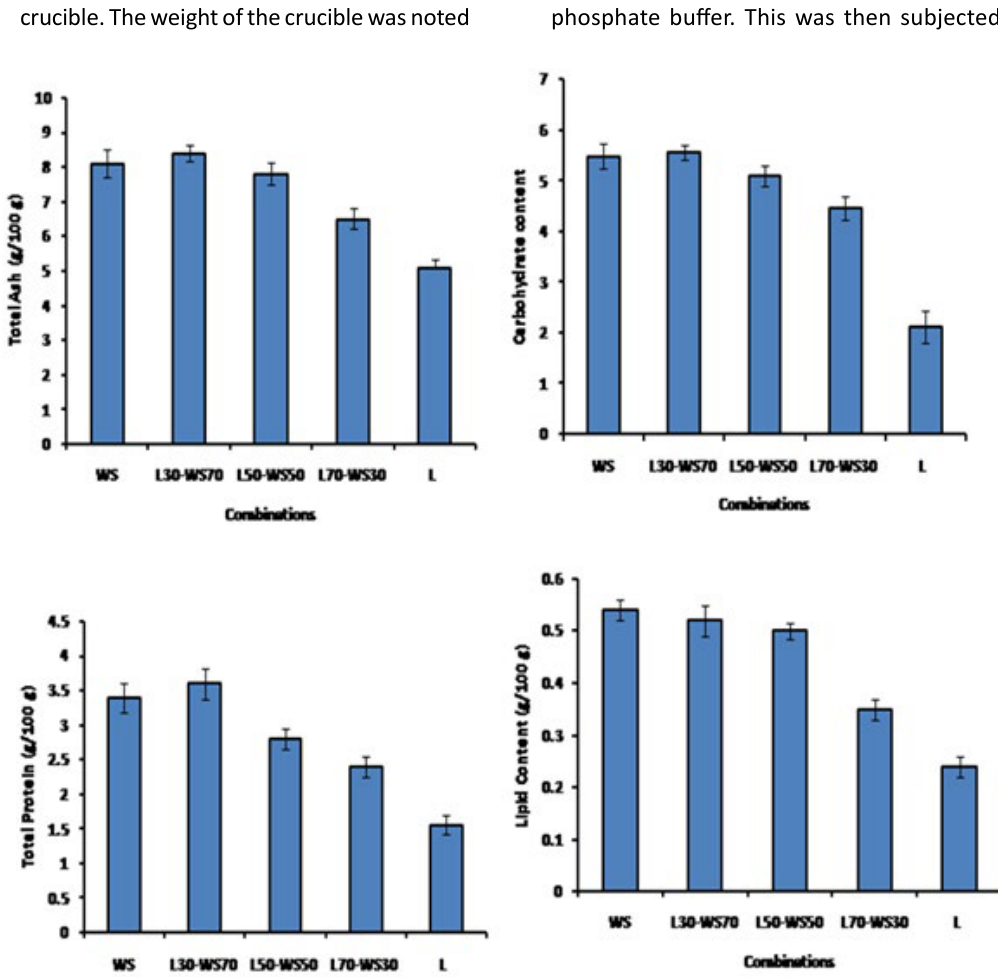
Fig. 3. Nutrient content of fresh mushrooms in different combinations (g of nutrient/100